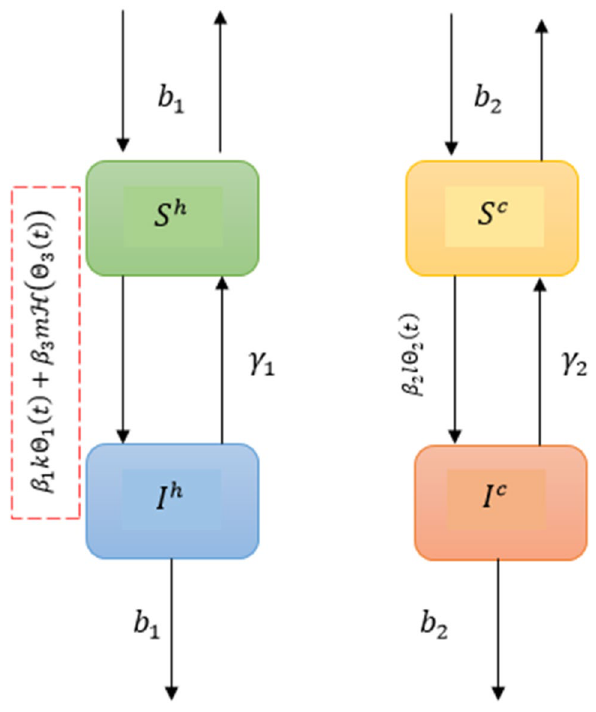
Figure 1. Dynamics diagram of Model